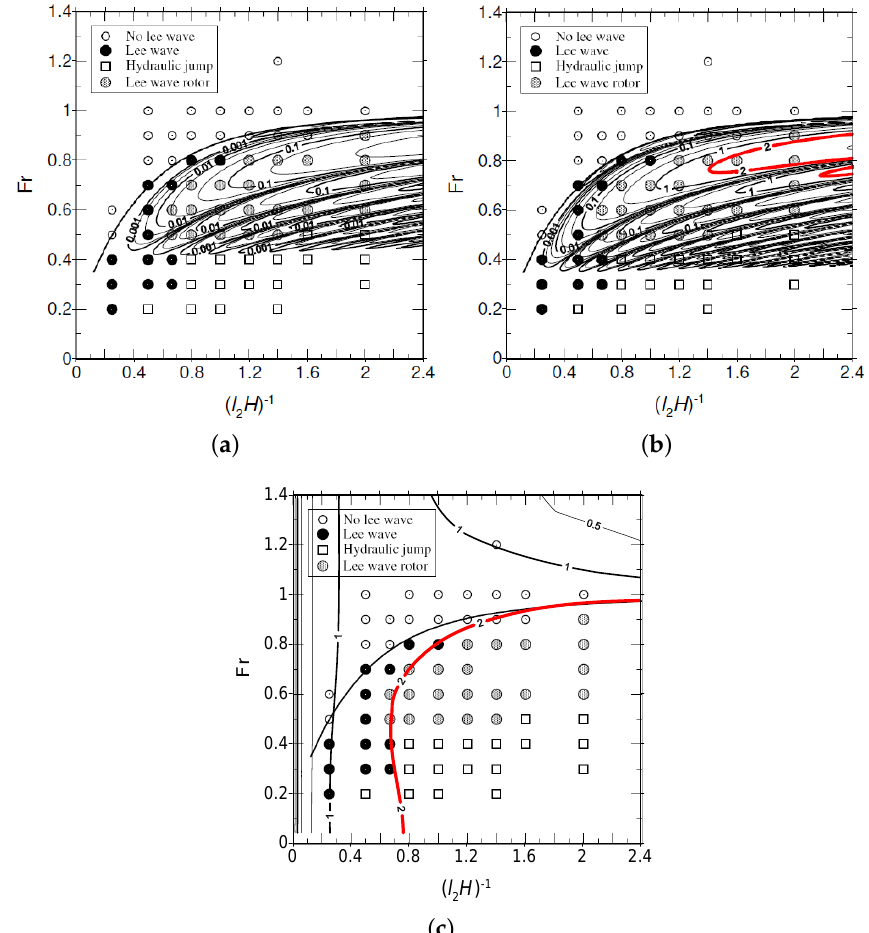
Figure 1. Inverse of the critical dimensionless mountain height [( l 2 h 0 ) crit ] − 1 as a function ( l 2 H ) − 1 and Fr for l 2 a = 12.5, superposed on V04’s regime diagram (adapted from Figure 9 of V04). Contours: 5, 2, 1, 0.5, 0.2, 0.1, and so on. The contour of two is denoted by a thick red line. ( a ) Inviscid model Equation (25); ( b ) improved model Equation (26); ( c ) full